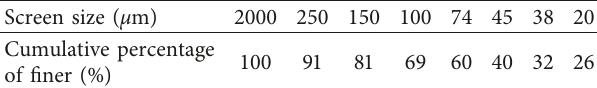
Table 1: Particle size distribution of the iron